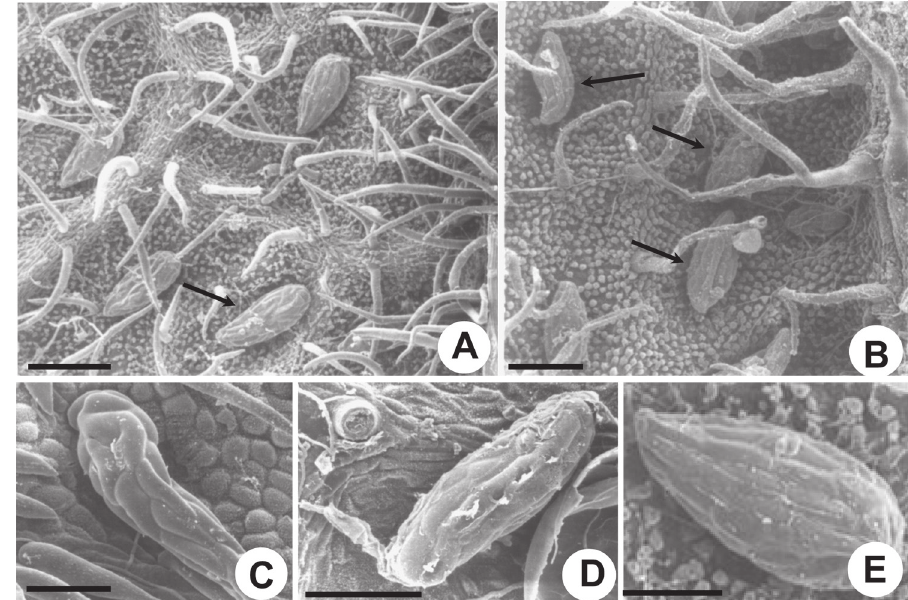
Figure 3 - Scanning Electron Microscopy of leaf surface of subgenus Bauhinia . ( A ) Abaxial side of leaf of B. aculeata (RB 94867) with glands (arrows) and non-glandular trichomes, scale bar = 150 µm. ( B ) Glands (arrows) at the base of a depression formed by protruding veins (left) of B. brevipes (SPF 142960), and papillate epidermal cells also can be seen, scale bar = 50 µm. ( C ) Detail of a gland on the abaxial surface of a leaf of B. forficata¸ scale bar = 50 µm. ( D ) Secretory gland of B. longifolia (SPF 122376), scale bar = 50 µm. ( E ) Detail of a single gland of B. aculeata (RB 94867), scale bar = 50 µm